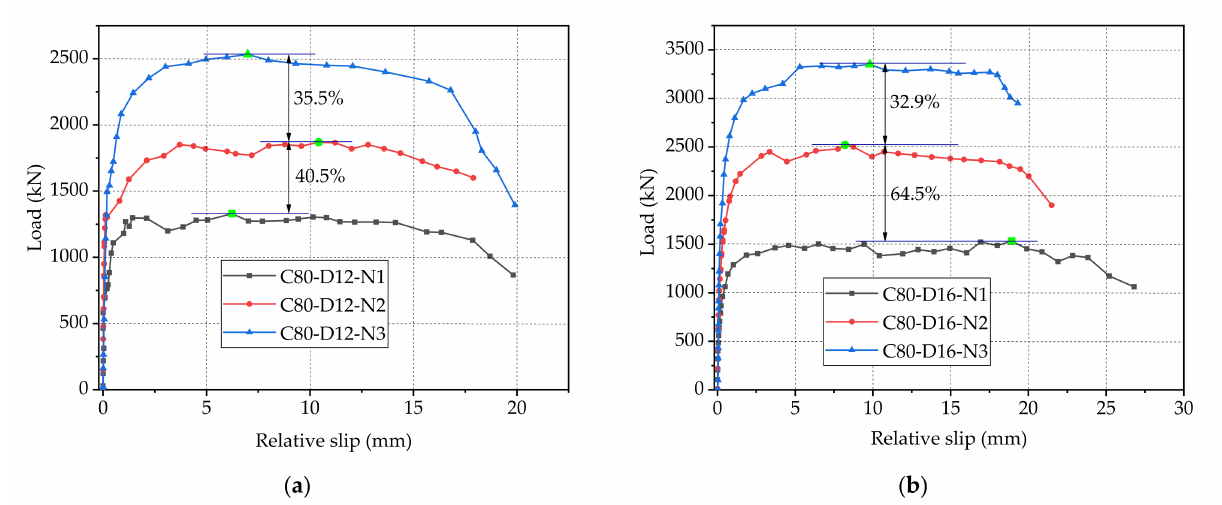
Figure 9. Load-slip curves of with different spacings of steel plate: ( a ) C80 concrete and 12-mm-diameter rebar; ( b ) C80 concrete and 16-mm-diameter rebar.